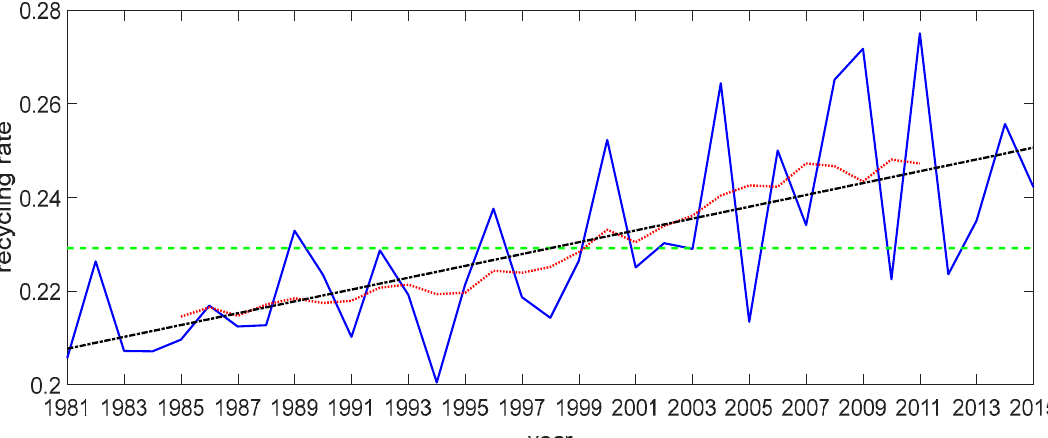
Figure 2. Annual average of precipitation recycling ratio in the middle and lower reaches of Yangtze River during 1981–2015 (Blue polyline). The green dotted line is the multi-year mean value, the black dotted line is the linear trend, and the red discount is the 9-year sliding mean value.